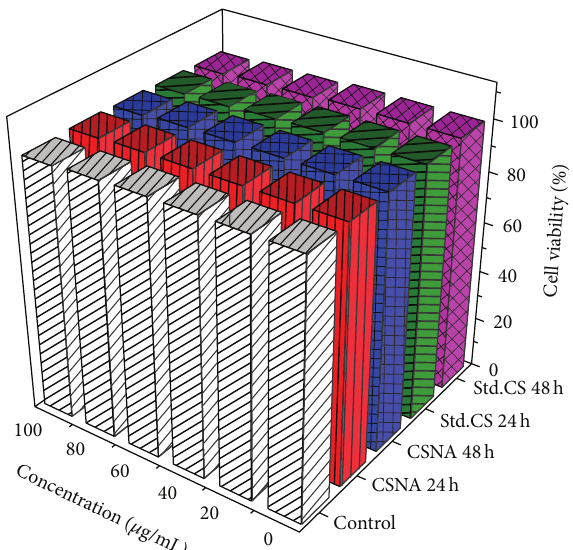
Figure 5: In vitro cell proliferation of HeLa against CSNA and Std.CS (24 h and 48h) measured using MTT